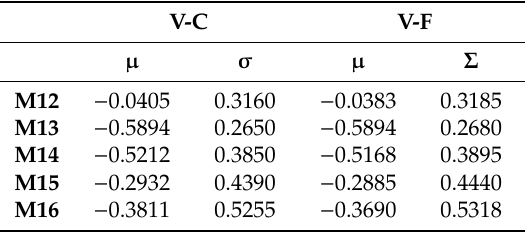
Figure 6. Global distributions of the V-C ( left panels ) and V-F ( right panels ) for M12 ( upper ), M15 ( middle ) and M16 ( bottom ) on 21 February 2020. Table 4. Global mean and STD for SNPP VIIRS on 21 February 2020 between V-C and V-F (V-C: di ff erence between VIIRS BT and CRTM BT; V-F: di ff erence between VIIRS BT and FCDN_CRTM BT; µ : V-C or V-F mean bias; σ : standard